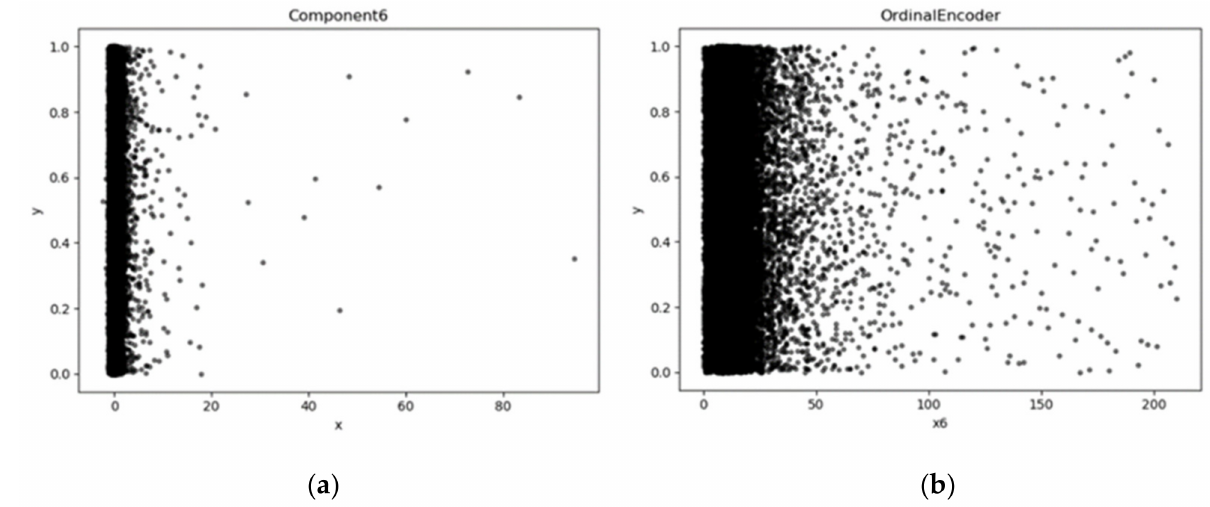
Figure 2. Plots of CH4 components data with OE normalization data for NG: ( a ) Below FA-selected 6th component named by CH4 and ( b ) normalization OE of component 6-CH4.